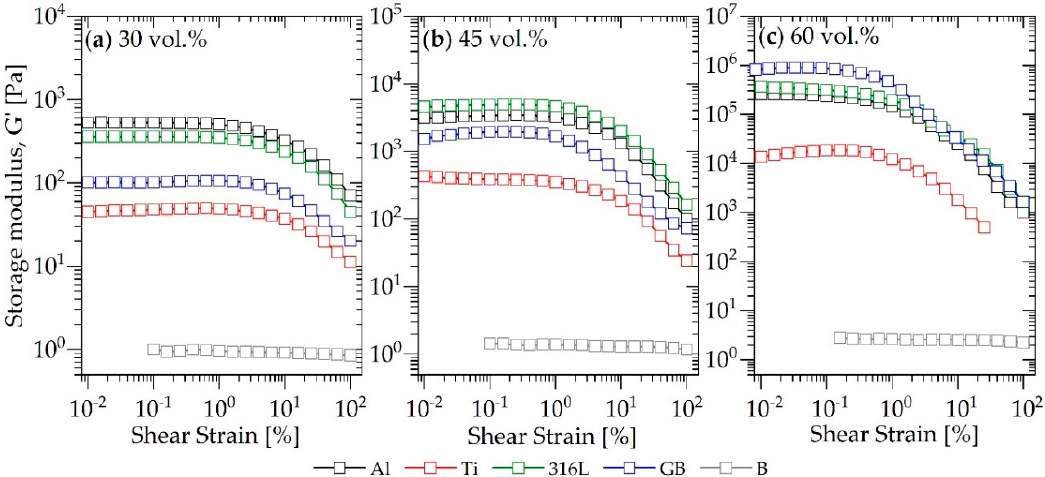
Figure 5. Strain amplitude sweep tests and the effect of filler material on G ′ for ( a ) 30 vol.%, ( b ) 45 vol.%, ( c ) 60 vol.% filler loading at 175 °C and 6.28 rad/s.